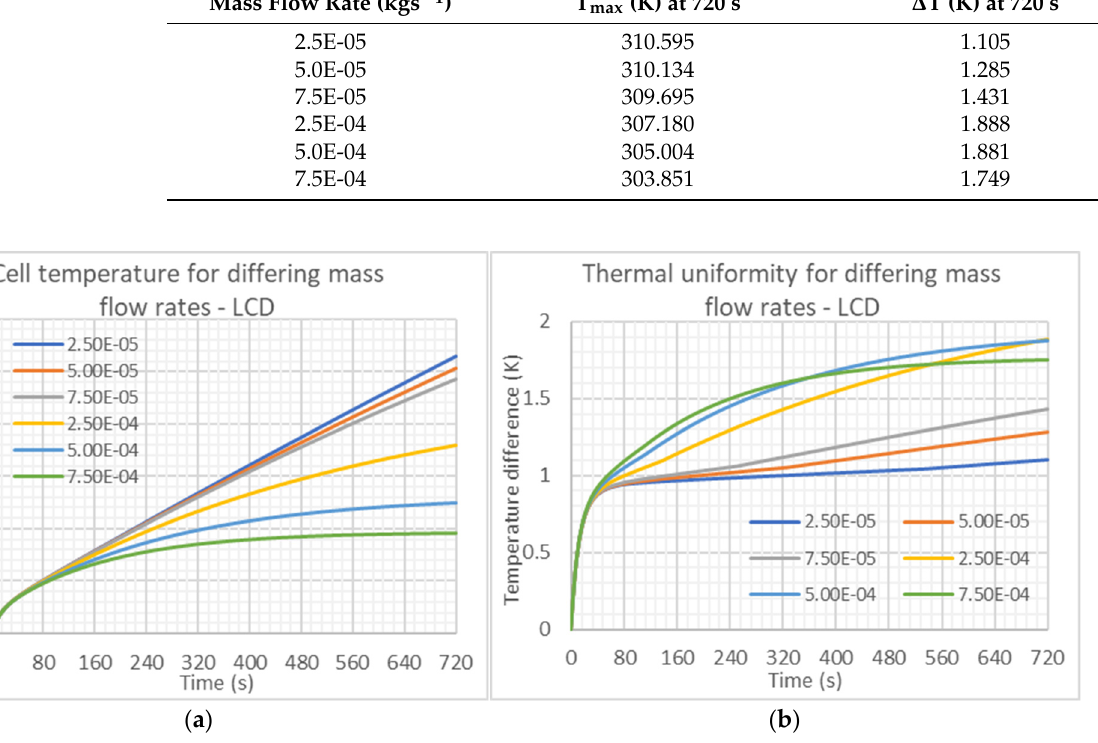
Figure 6. LCD-effects of mass flow rate on: ( a ) Maximum cell temperature; ( b ) Cell temperature difference. Table 3. Influence of mass flow rate at